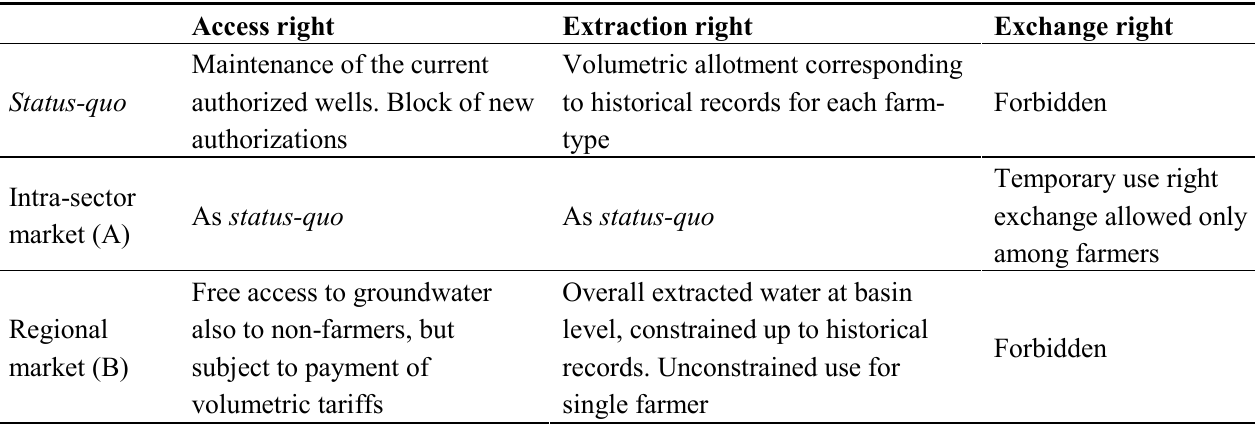
Table 3. Features of use rights